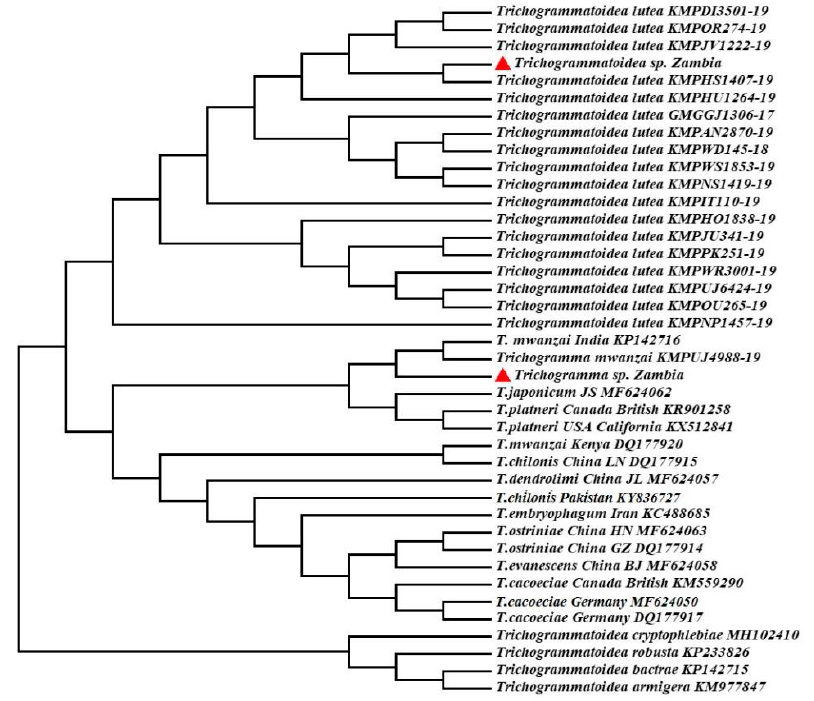
Figure 2. Molecular phylogenetic tree construction of Trichogramma and Trichogrammatoidea species based on the neighbor-joining method.